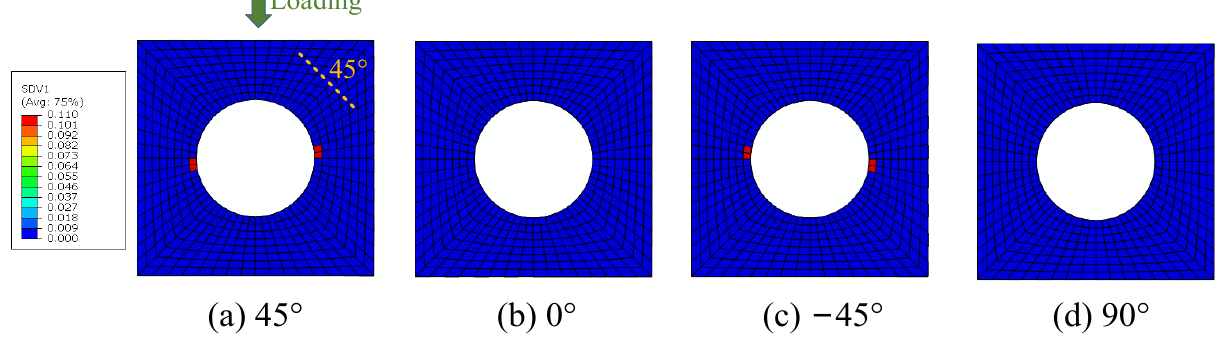
Figure 17. The initiations regions for fiber–matrix interface debonding.